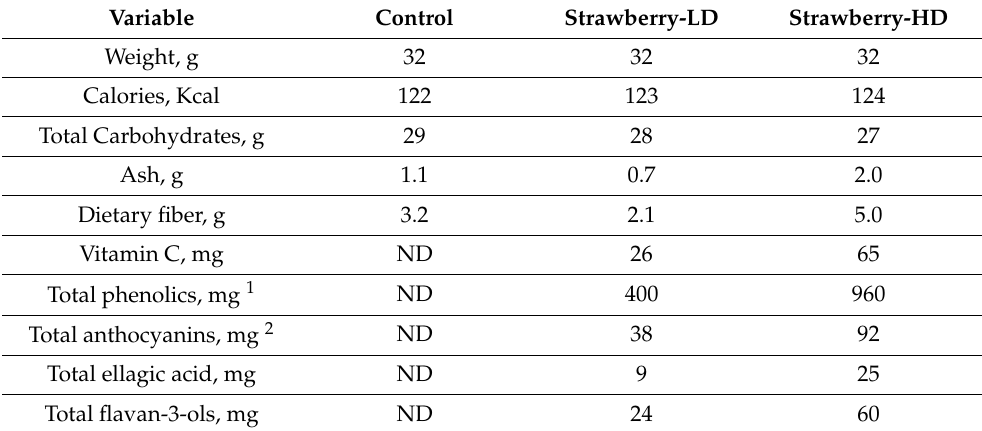
Table 1. Composition of test powders consumed per